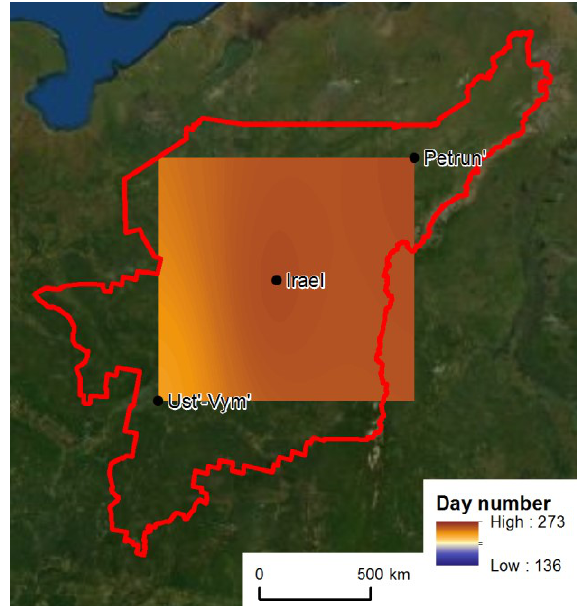
Figure 7. Beginning days of autumn growing season interpolated between meteorological stations